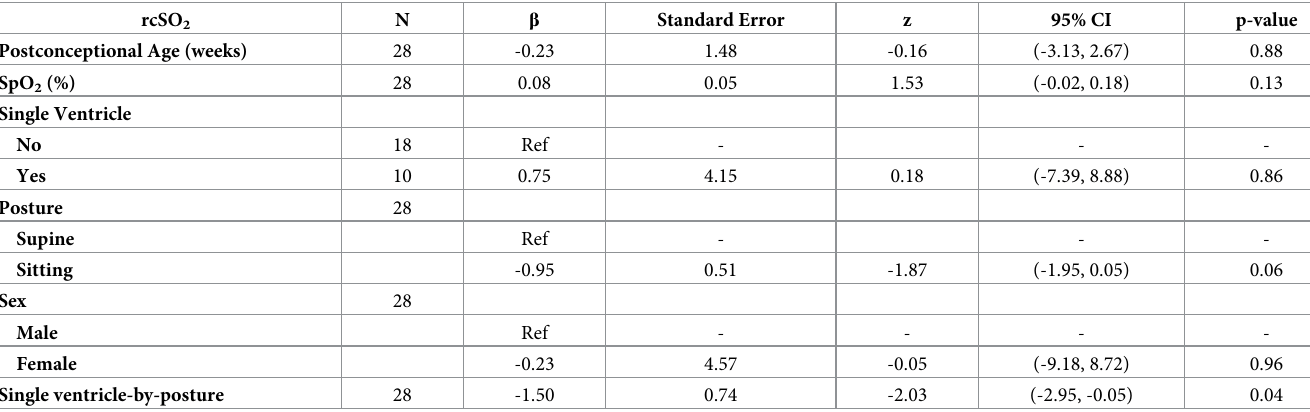
Table 4. Effects of single ventricle CHD on cerebrovascular stability.